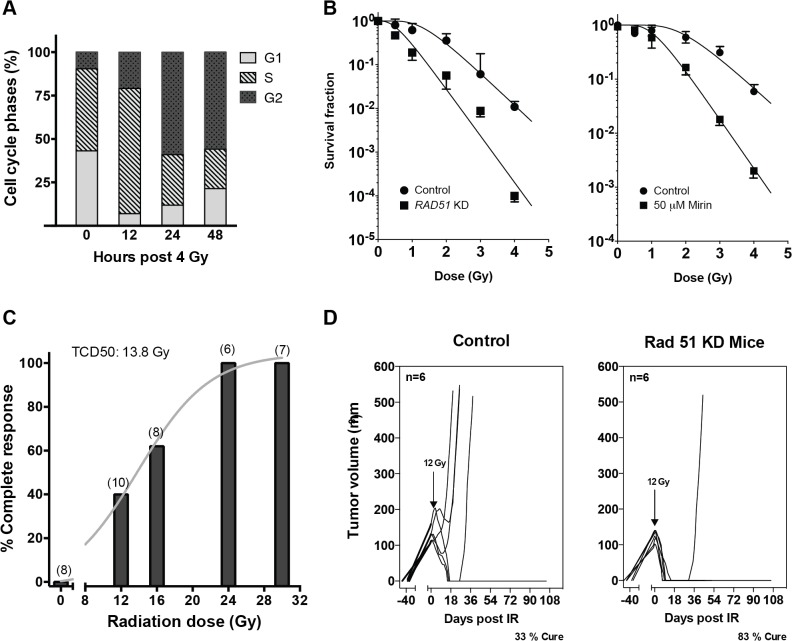
HDR inactivation radiosensitizes human Notch-driven cancer.(A) Cell cycle distribution of unirradiated and 4Gy-treated CUTLL-1 cells. DNA content was assessed by propidium iodide incorporation and FACS analysis. (B) Targeting RAD51 or inhibiting the Mre11-Rad50-Nbs1 complex radiosensitizes CUTLL-1 cells. Clonogenic survival was performed in CUTLL-1 cells expressing human RAD51 shRNA or non-silencing control shRNA (left), or in cells treated with or without 50 μM Mirin (right). Surviving colonies (>50 cells) were scored at 11–14 days post irradiation. Data represent three independent experiments for each assay. (C) Complete CUTLL-1 tumor response after single dose radiotherapy. CUTLL-1 chloromas (100–150 mm3) in flanks of NOD-SCID female mice were irradiated, and tumor volumes were measured using calipers 2x weekly for 3 months. Complete response was defined as lack of measurable tumor. Parentheses denote number of mice⁄group. The curve was fit to data by nonlinear regression analysis using the Prism Sigmoidal Curve Fit program. (D) RAD51 inactivation radiosensitizes Notch-driven tumors. NOD-SCID female mice harboring RAD51 shRNA-expressing CUTLL-1 xenografts (KD RAD51) or non-silenced control CUTLL-1 tumors (control) were treated with 12Gy and tumor size measured as in (C).